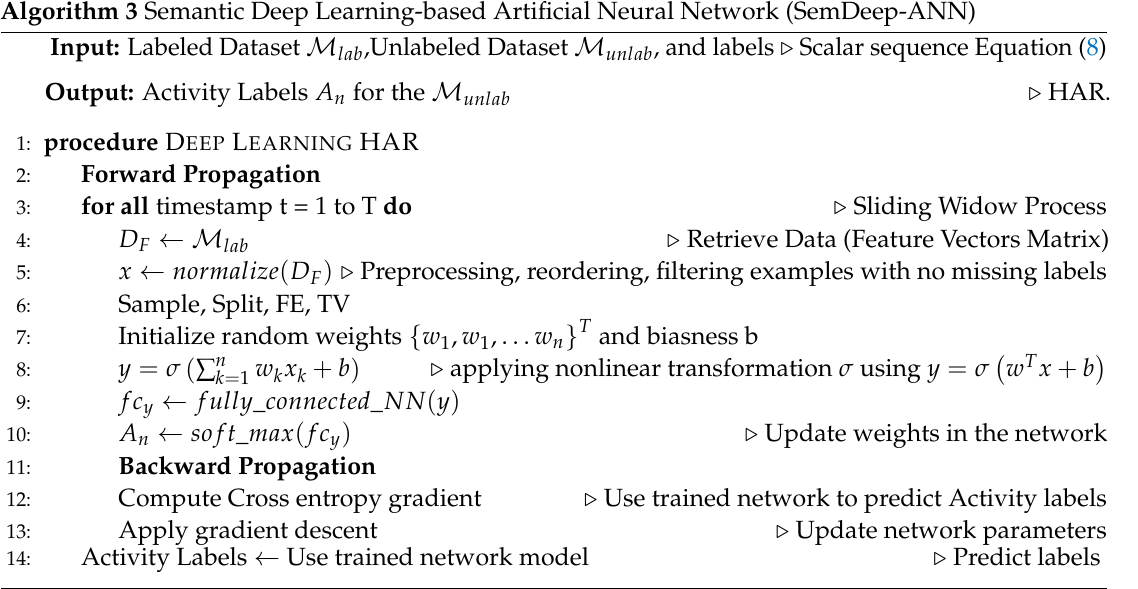
Algorithm 3 Semantic Deep Learning-based Artificial Neural Network